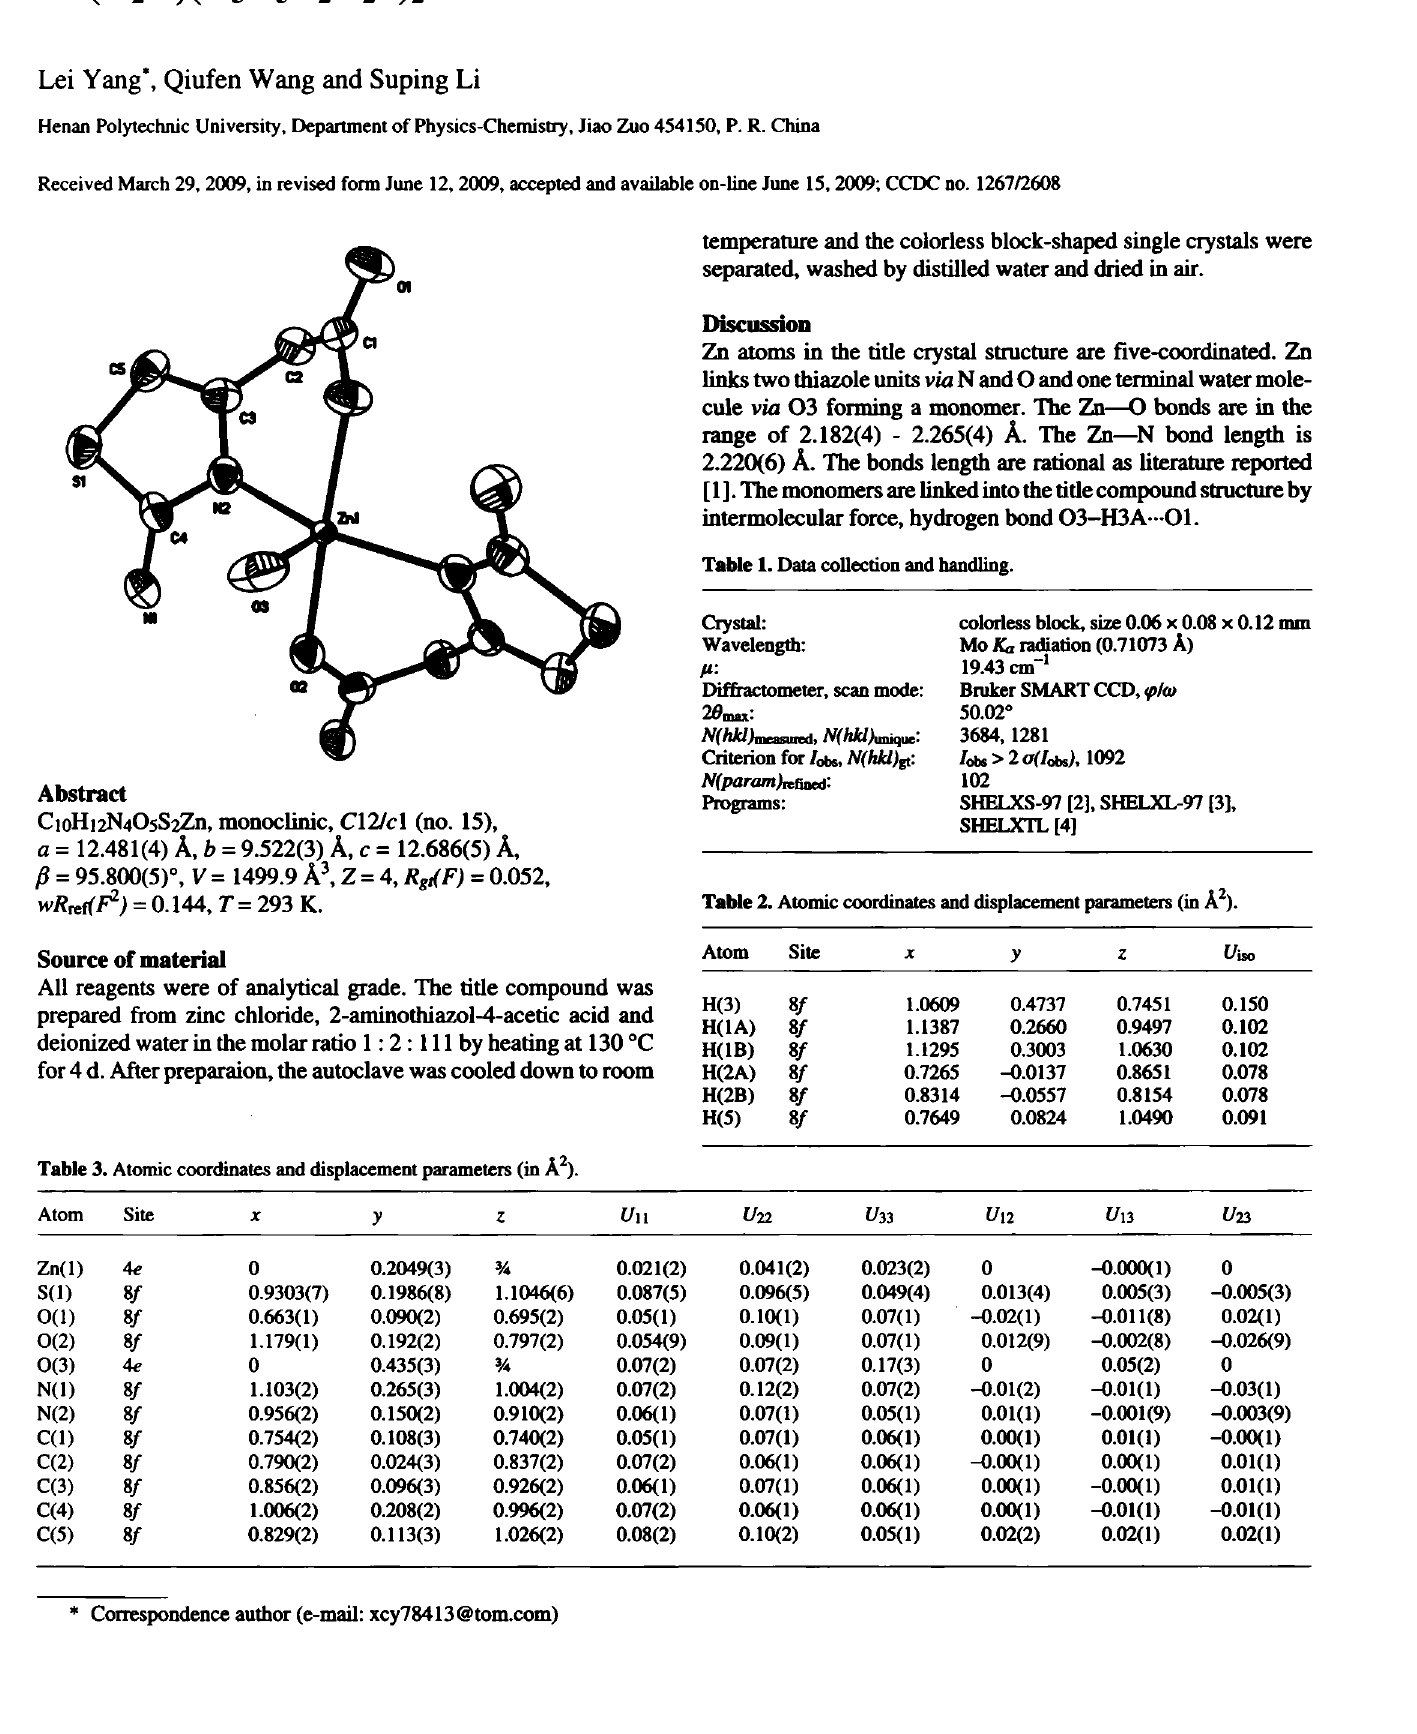
Table 3. Atomic coordinates and displacement parameters (in À 2 ).